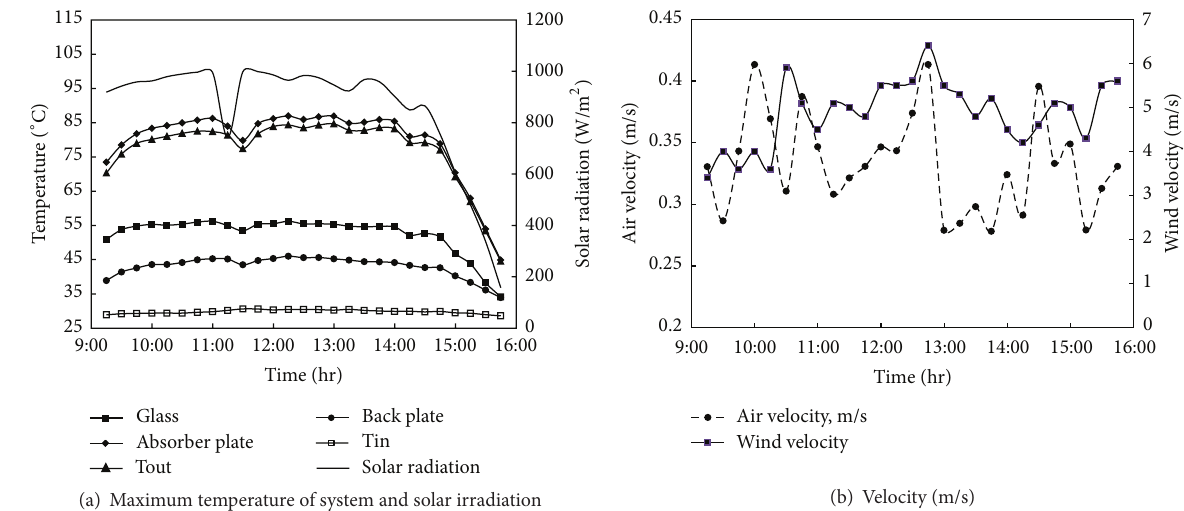
Figure 12: Surface temperature variation at different location and weather condition (September 18, 2013).